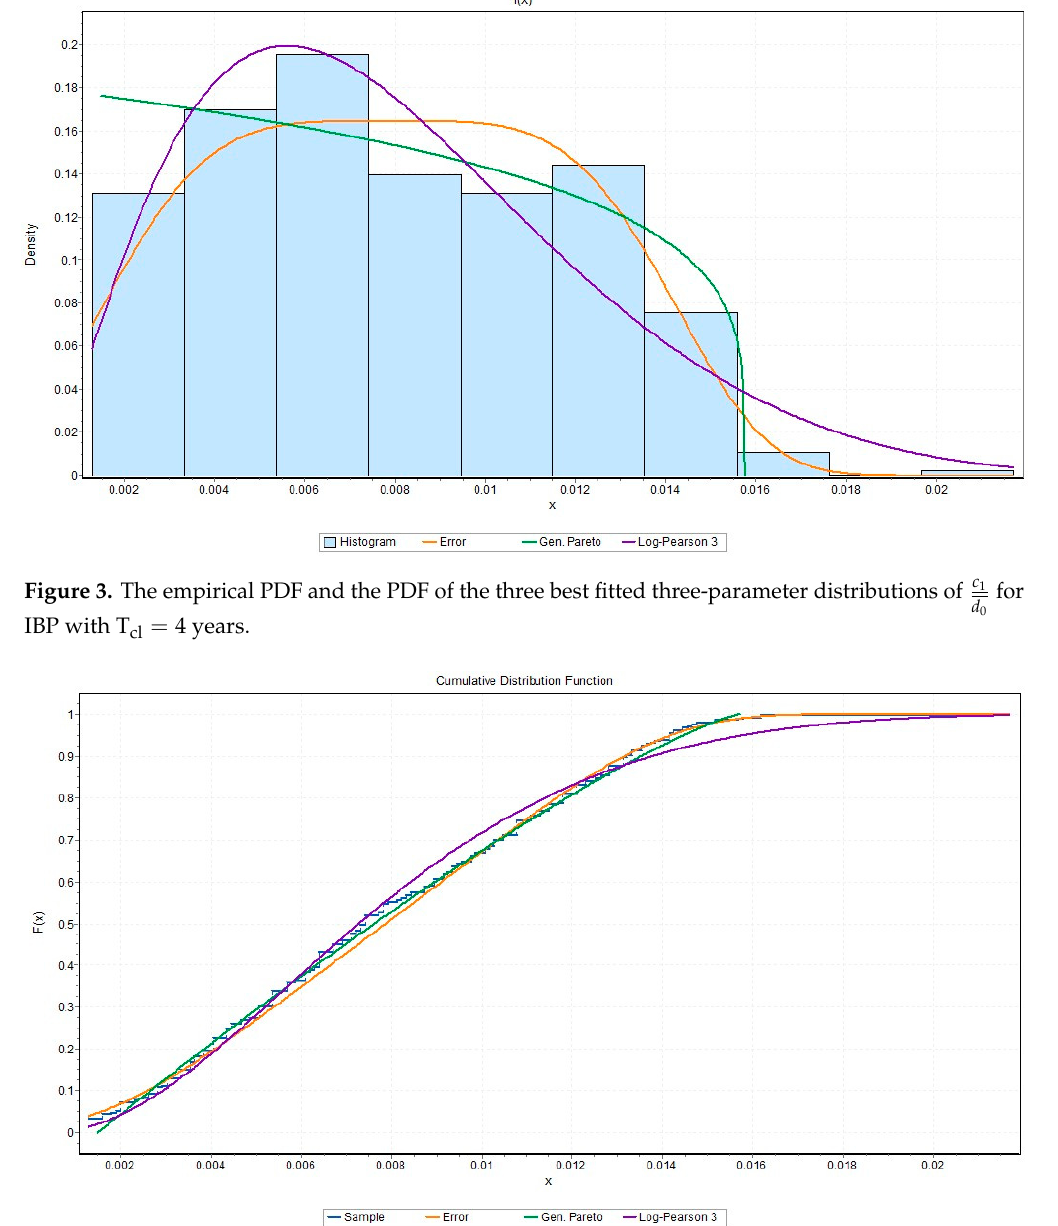
Figure 4. The empirical CDF and the CDF of the three best fitted three-parameter distributions of c 1 for IBP with T cl = 4